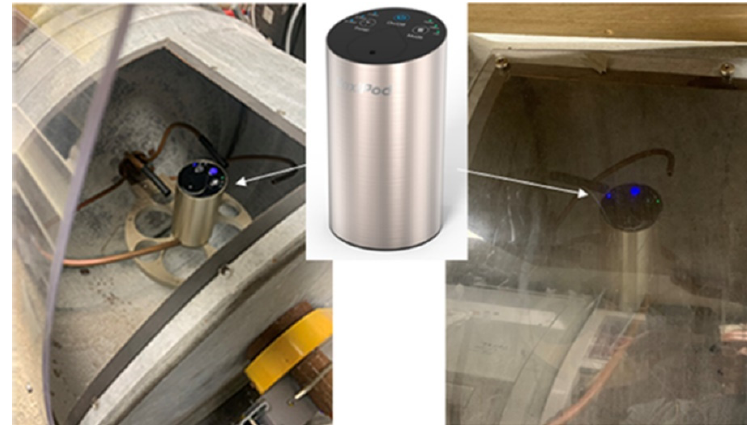
Figure 3. Location of oil atomiser inside rotational aerosol chamber.